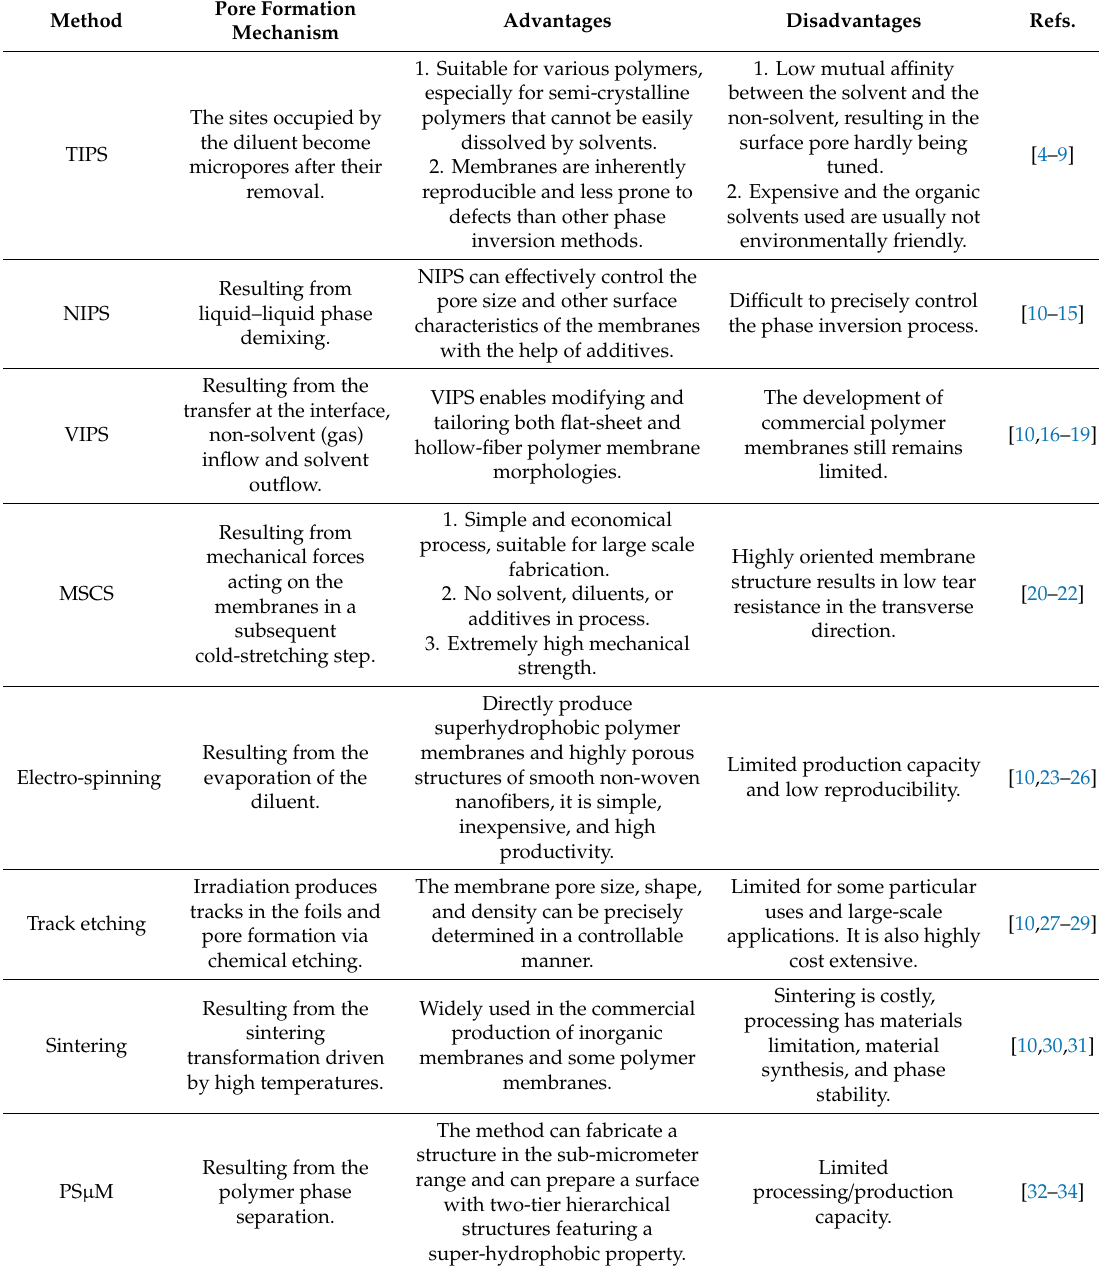
Table 1. Various preparation methods for porous polymeric